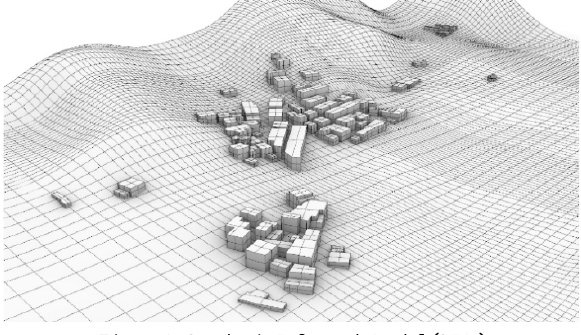
Figure 9. Synthetic Informed Model (SIM)